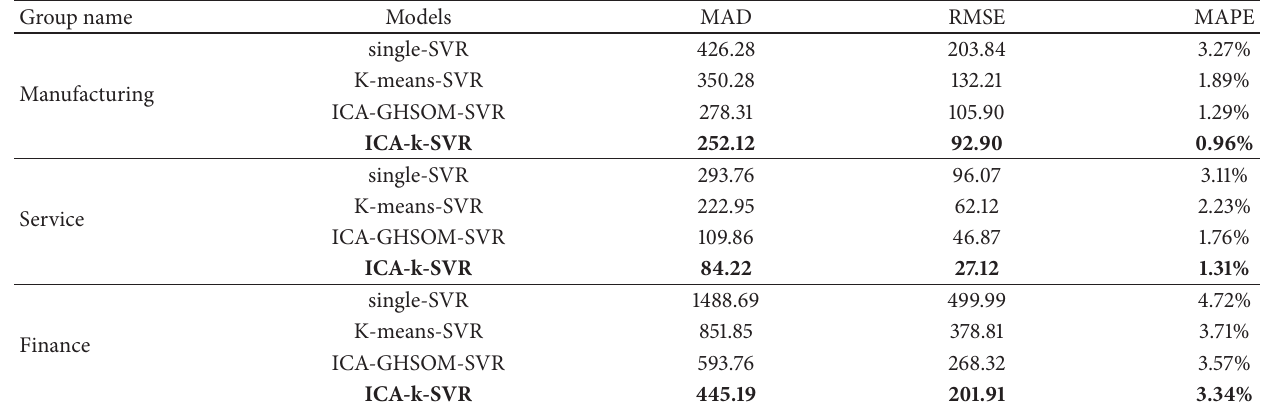
Table 8: Summary of forecast results by the four